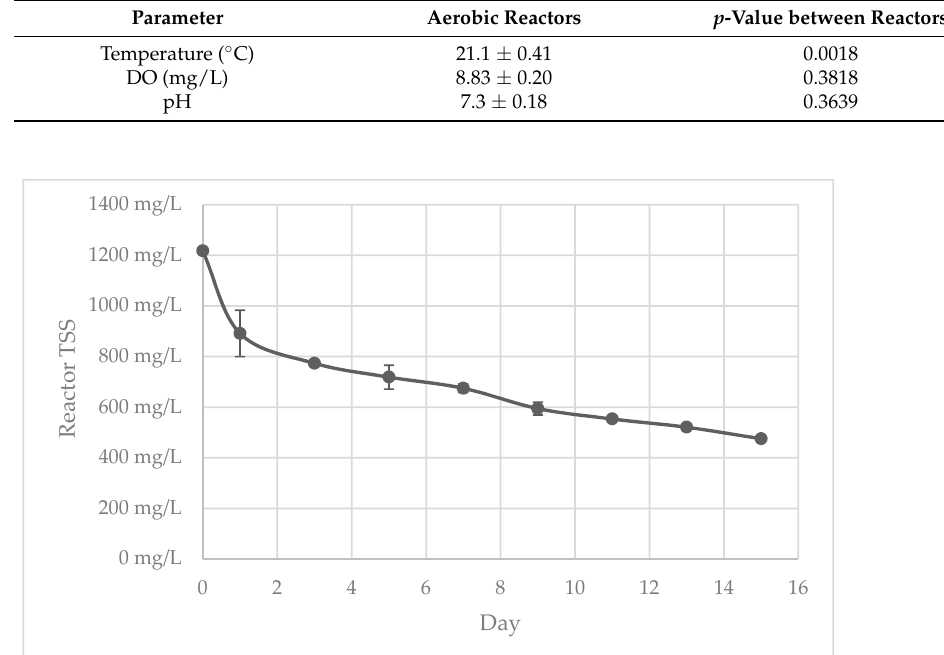
Figure 2. Mean TSS concentration within aerobic reactors throughout the 15-day study period. Error bars indicate standard deviation between treatment replicates.